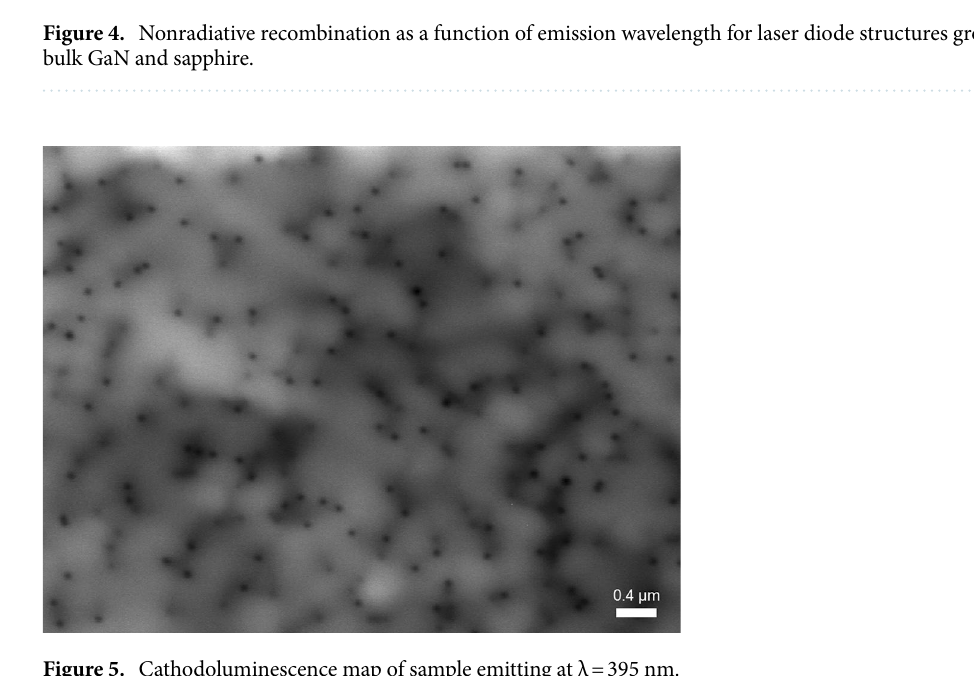
Figure 5. Cathodoluminescence map of sample emitting at λ = 395